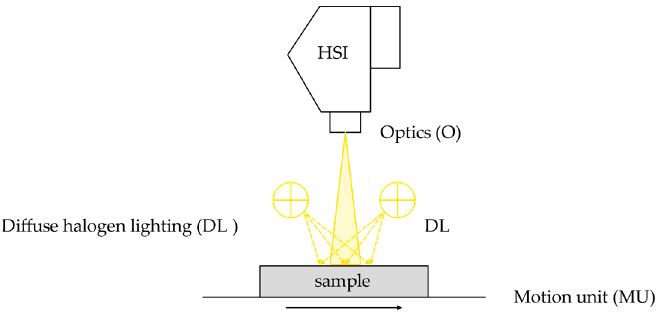
Figure 3. Schematic representation of the hyperspectral imaging system. HSI: VNIR or NIR-HSI camera. O: optics of the HSI camera. DL: diffuse halogen lighting. MU: motion unit. camera. O: optics of the HSI camera. DL: diffuse halogen lighting. MU: motion